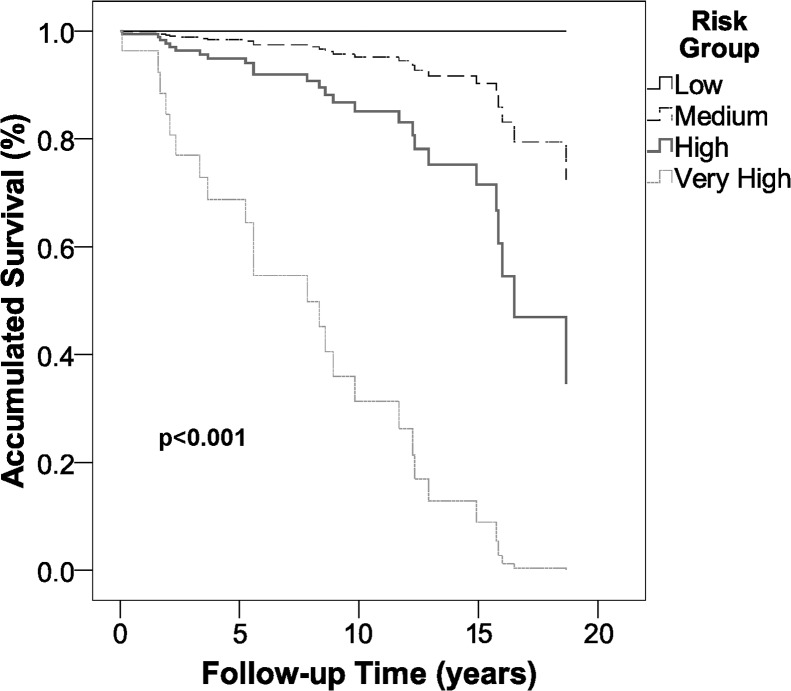
Survival of the different risk groups.